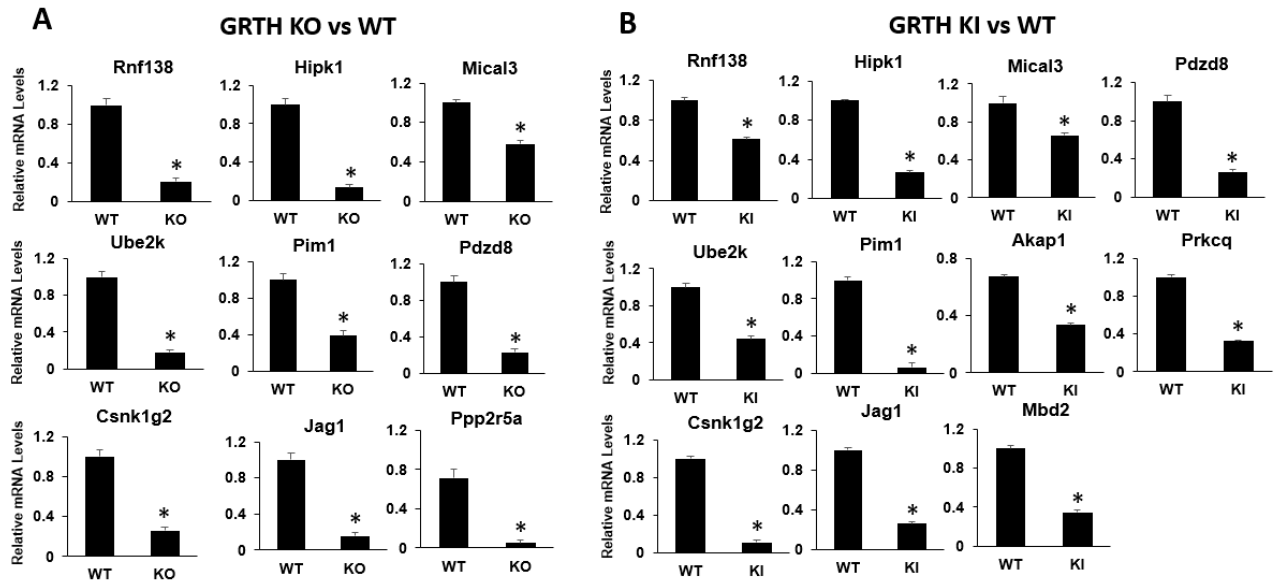
Figure 3. qRT-PCR analysis of selected DEGs of mRNA from RS of KO and KI groups. Bar graphs represent the fold change expression between ( A ) KO vs. WT or ( B ) KI vs. WT groups. Means ± SEM were determined from three independent qRT-PCR experiments with each sample run in triplicates. p values were calculated by a two-tailed Student t-test (asterisks indicate p < 0.05).